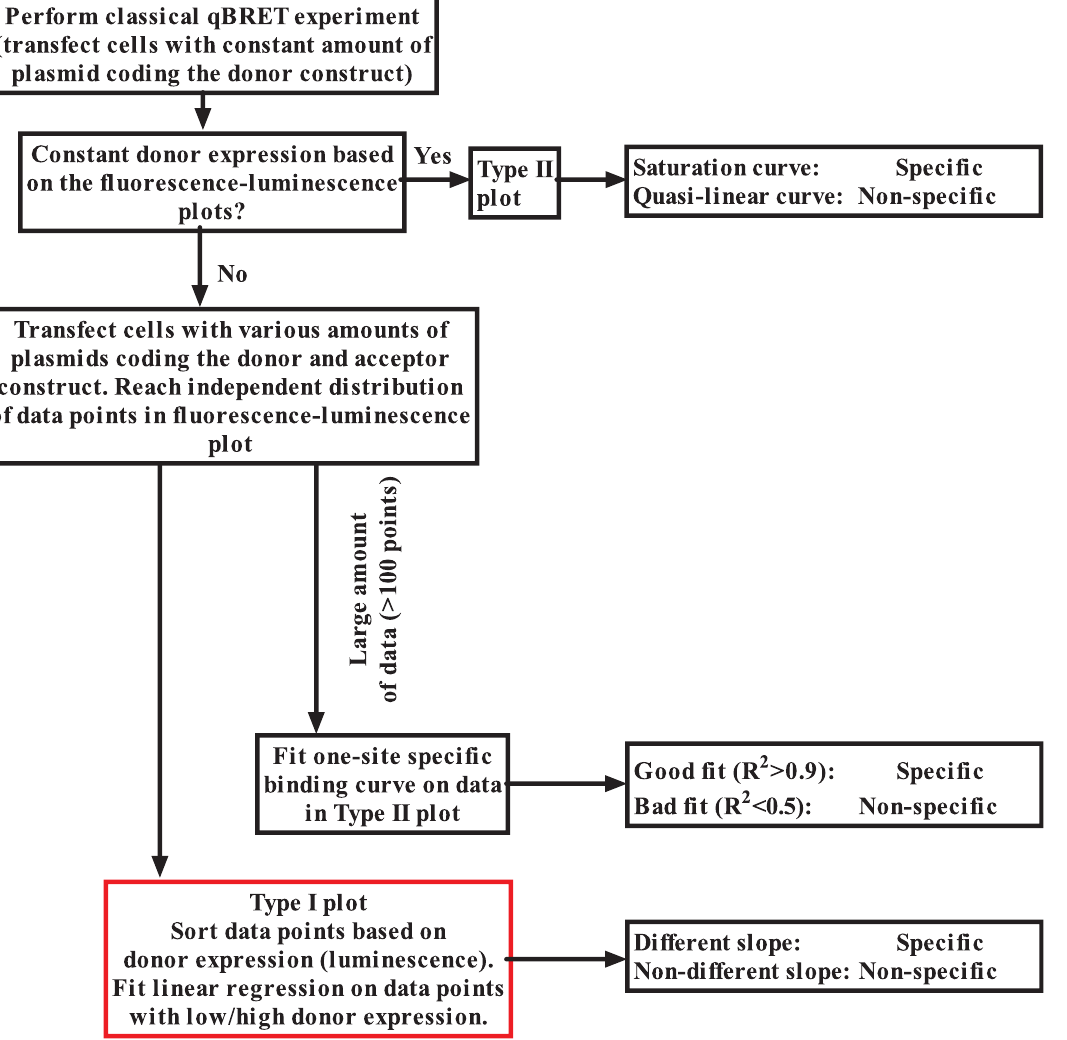
Figure 5. Preferred method to perform qBRET experiments. In Type I plots BRET ratio is plotted as a function of acceptor expression (fluorescence), while in Type II plots BRET ratio is plotted as a function acceptor/donor expression